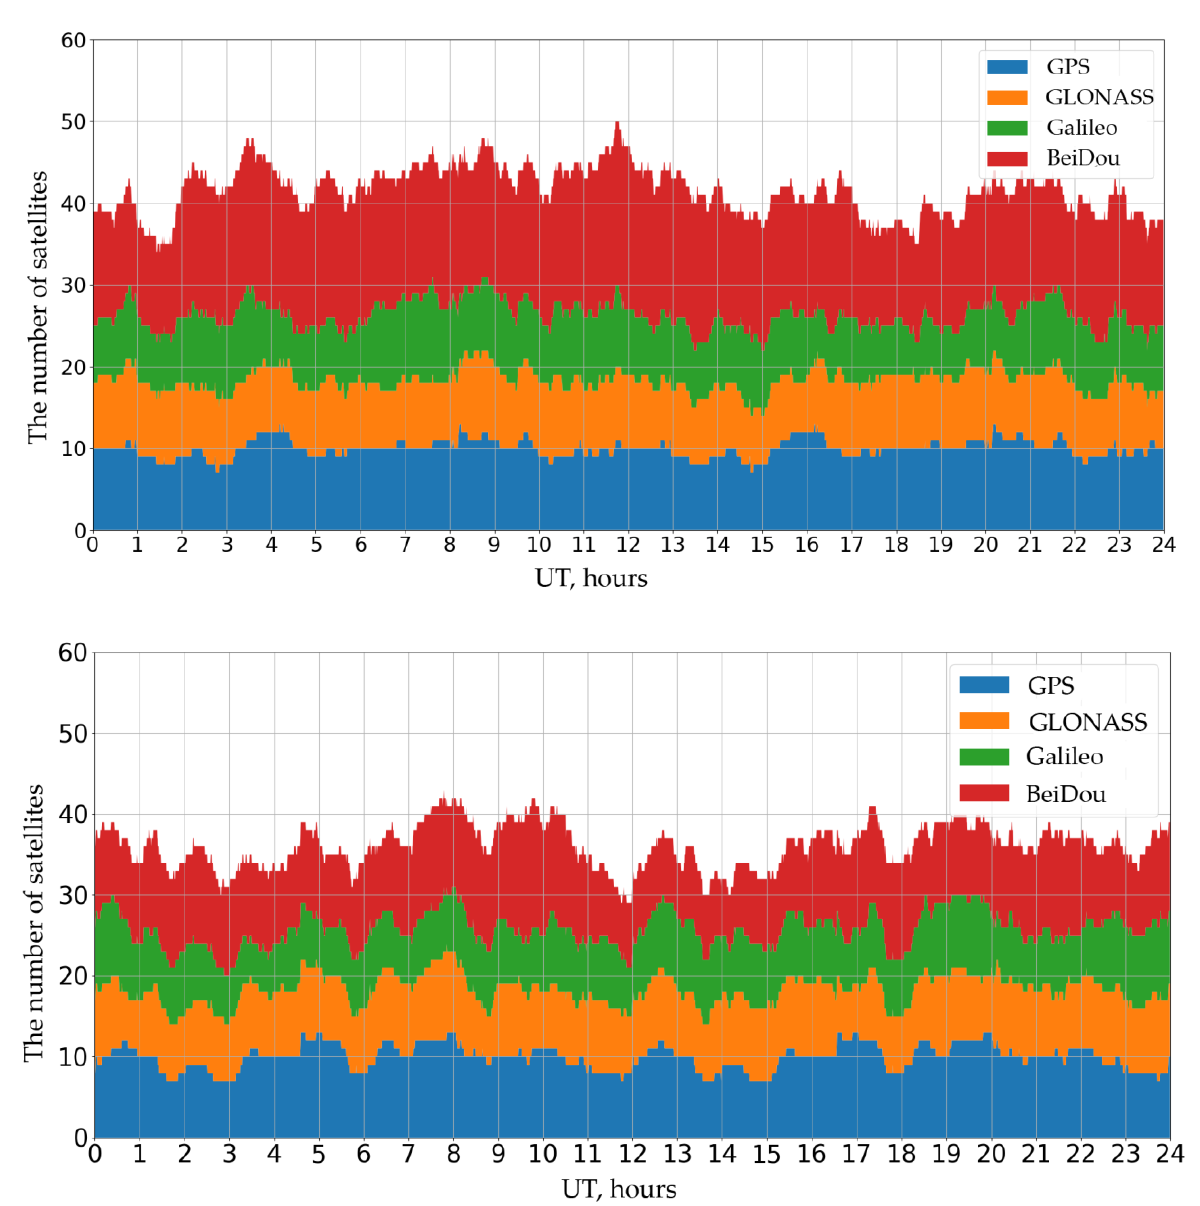
Figure 8. Integrated number of observed satellites for different systems: GPS — dark blue, GLONASS — orange, Galileo — green, BeiDou — red. Top: data for the Asian sector (52°N, 100°E); bottom: the American sector (52° N, − 100° E). By the results of the 10 October 2020 ephemerids.